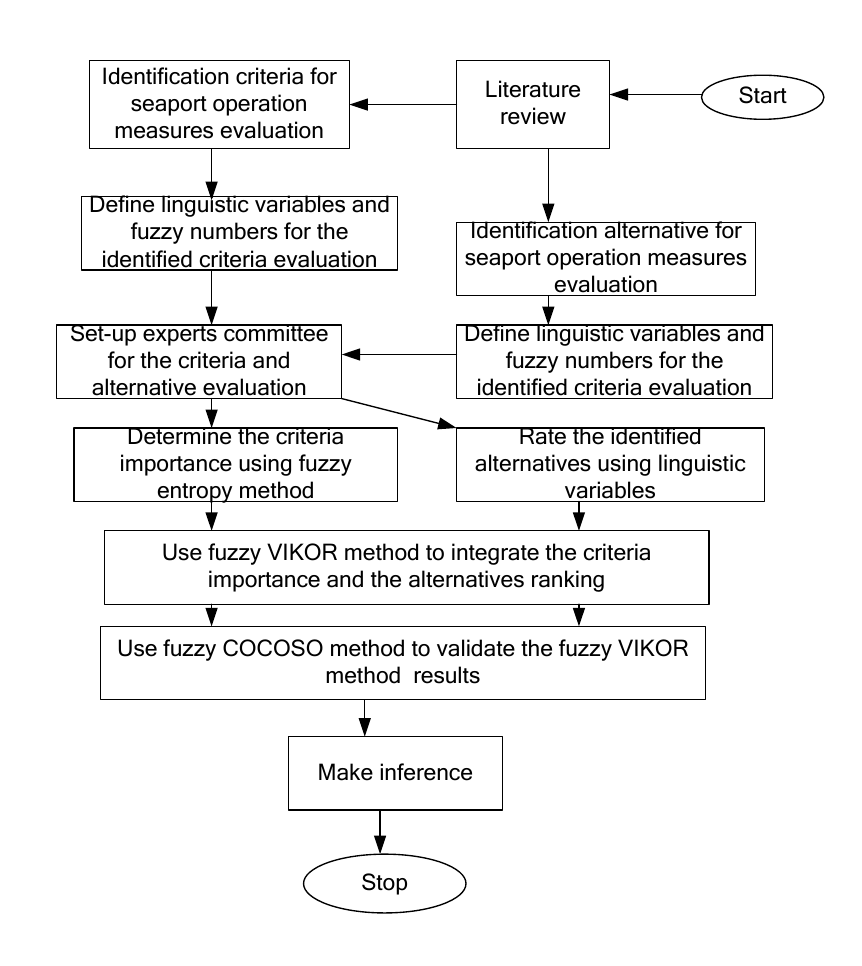
Fig. 1. Proposed framework for seaports operation measures